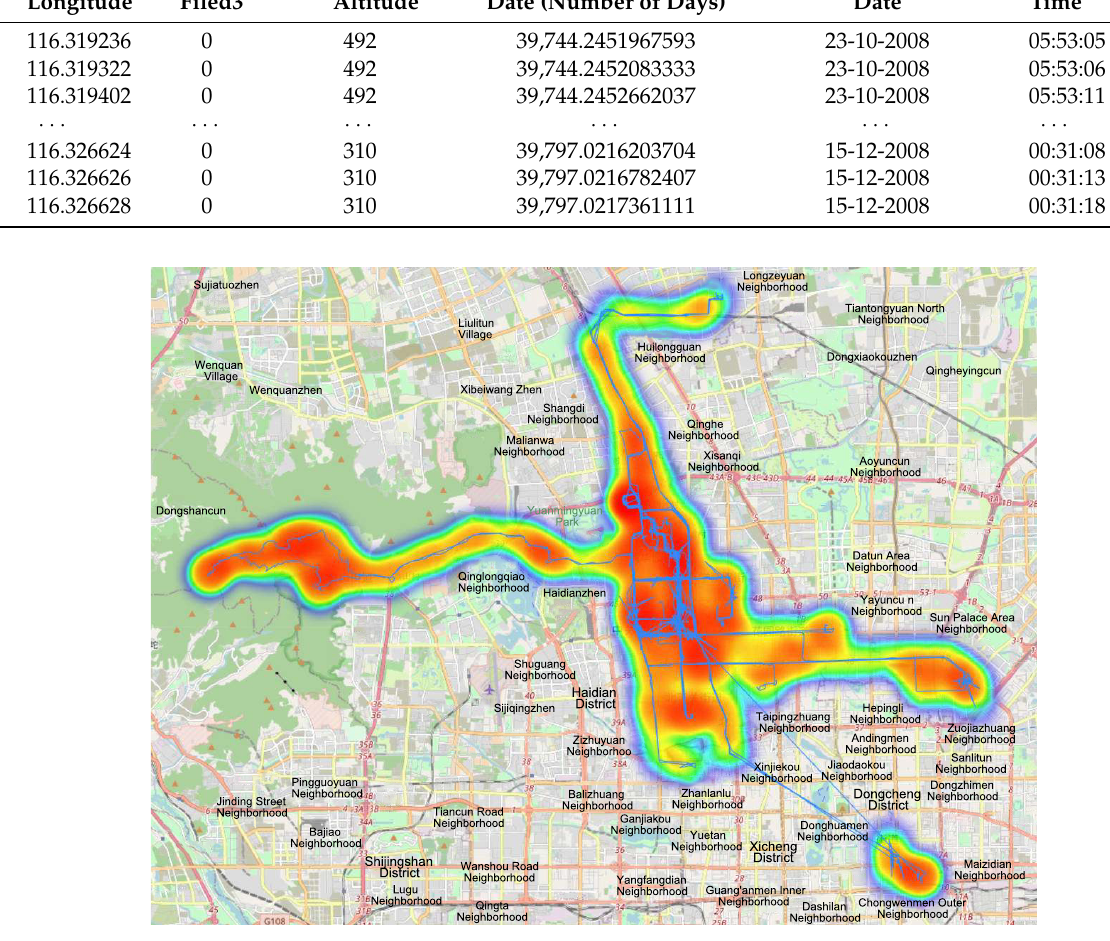
Figure 5. Track data distribution of user